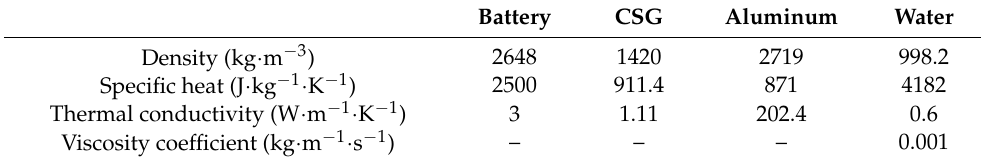
Table 5. Thermo-physical properties of the materials in the